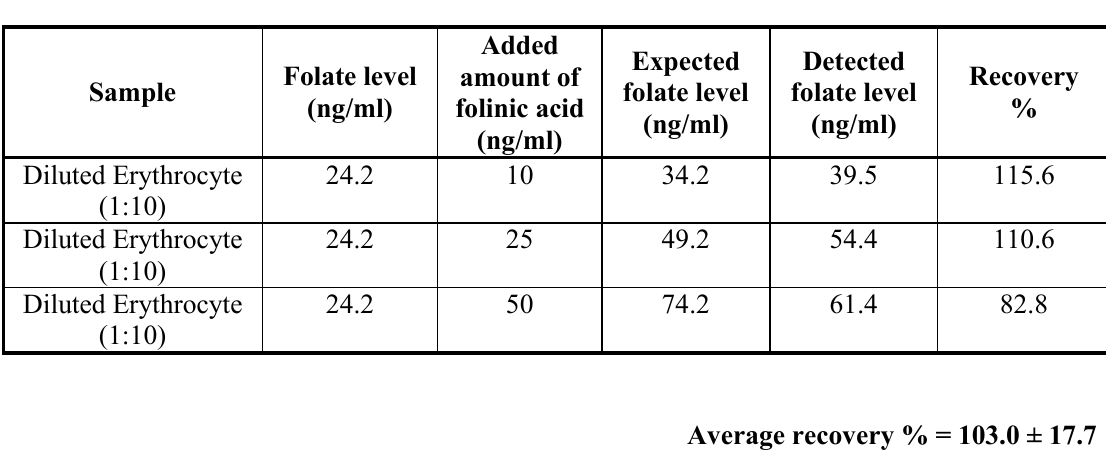
Table 1. Recovery of the microbiological